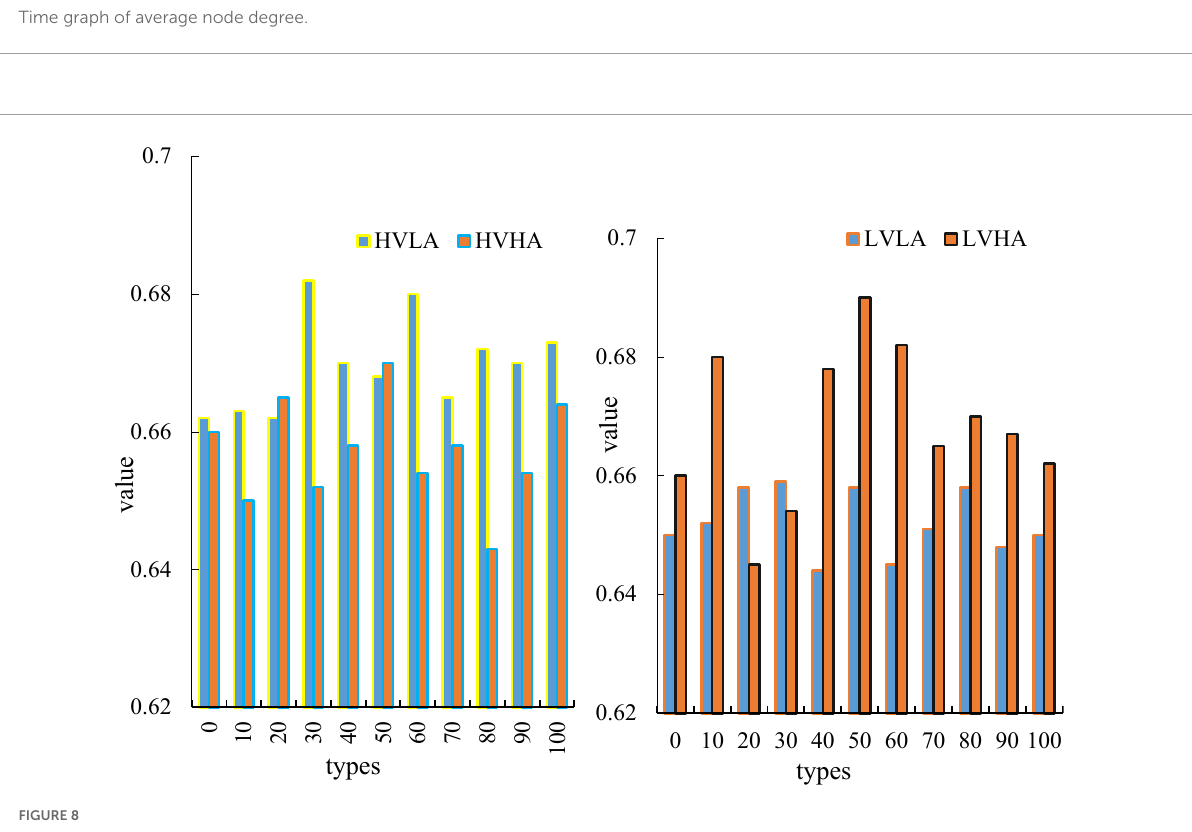
FIGURE8 Time variation plot of average clustering